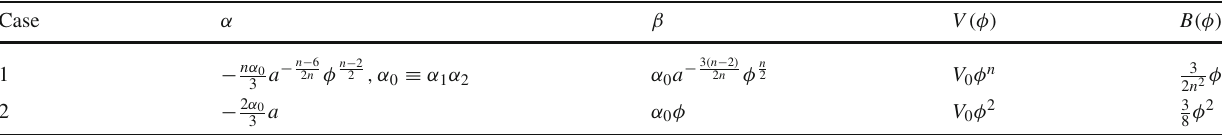
Table 1 Set of solutions of the Noether symmetry equations